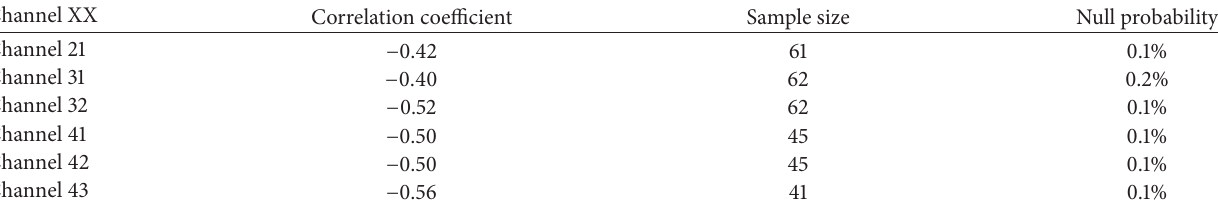
Table 2: Correlation coefficient between lag and isotopic luminosity.